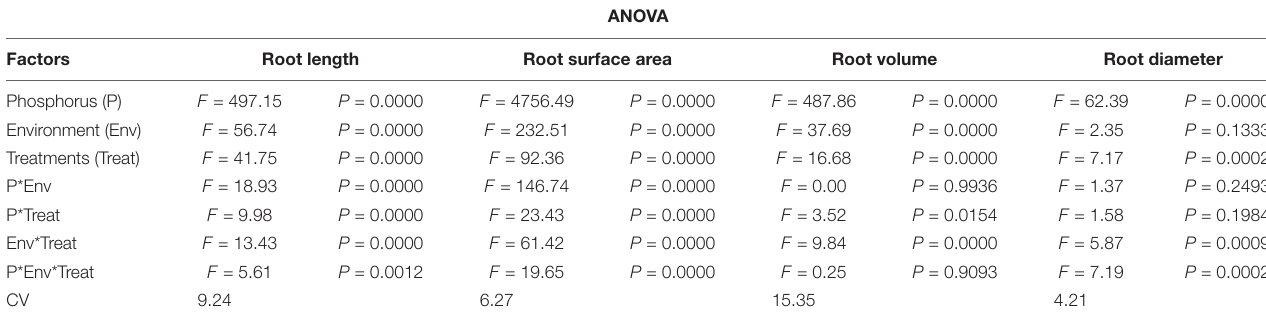
TABLE 5 | Values under ANOVA are the F-test, probabilities ( P value) and coefficient of variation of the sources of variation (LSD, P < 0.05).